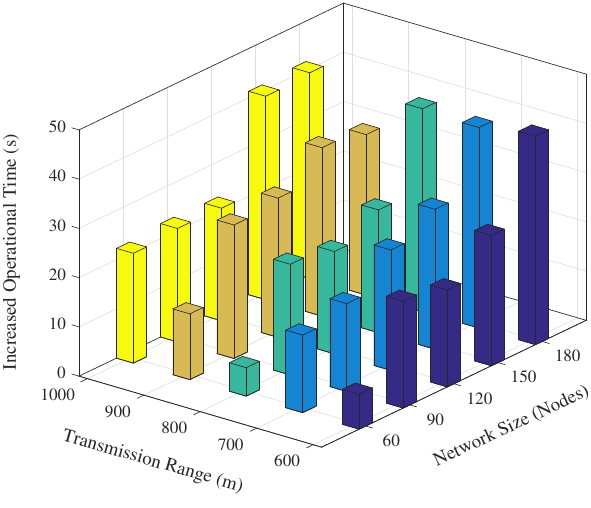
Figure 20. Overall increase network lifetime by the proposed EDOVE.